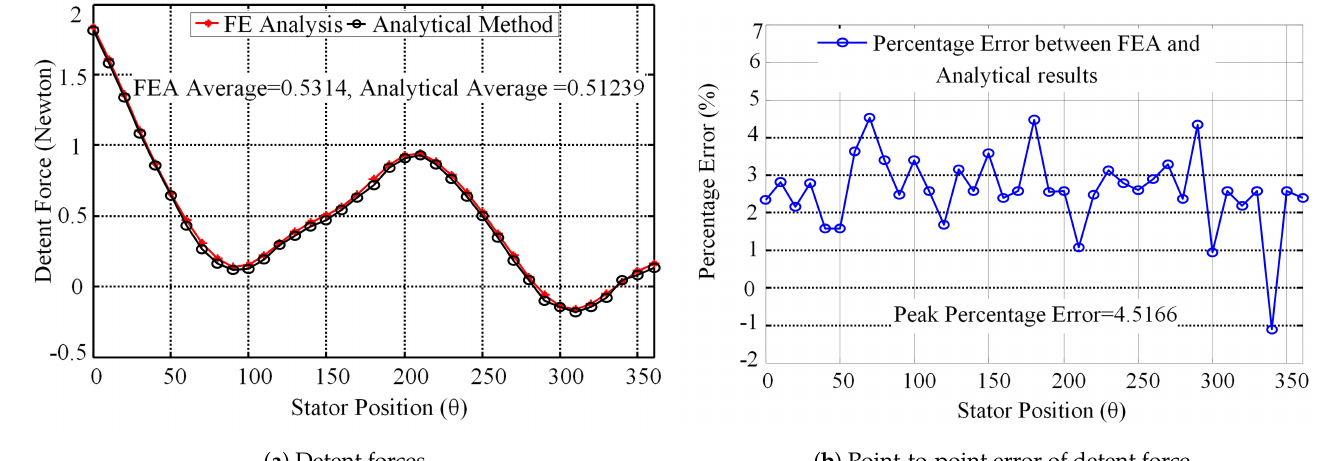
Figure 15. FE and analytical method comparison for Detent